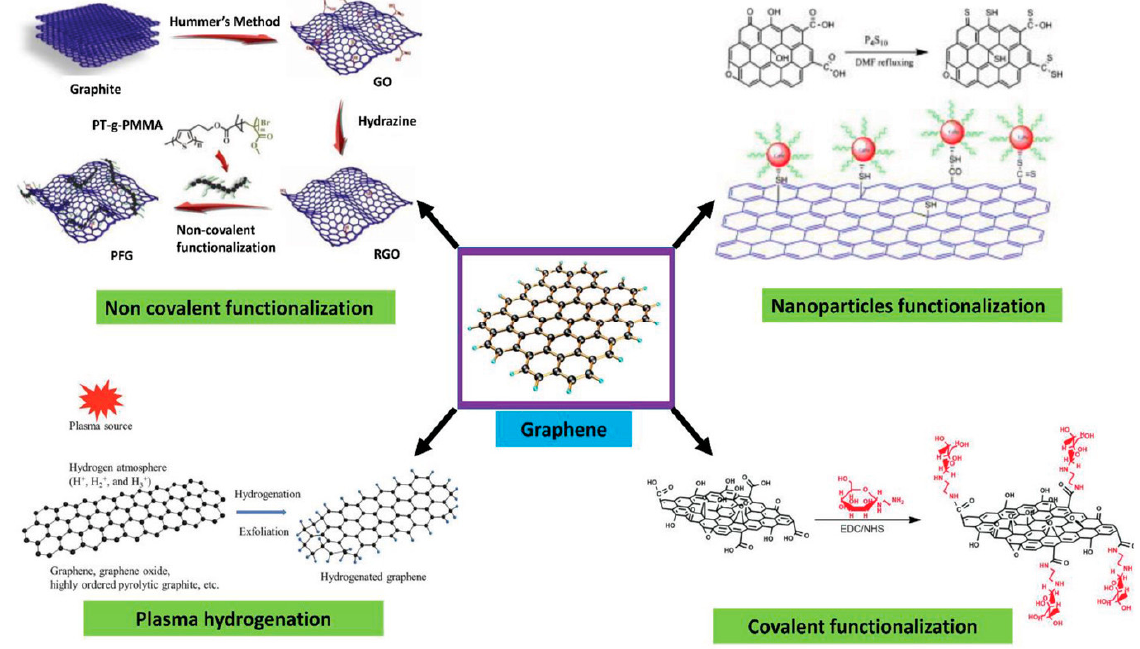
Figure 3. Surface functionalization strategies for graphene-based materials. Reproduced with permission from Ref. [17]. Copyright 2021 Wiley. Licensed under a Creative Commons Attribution (CC BY) License.